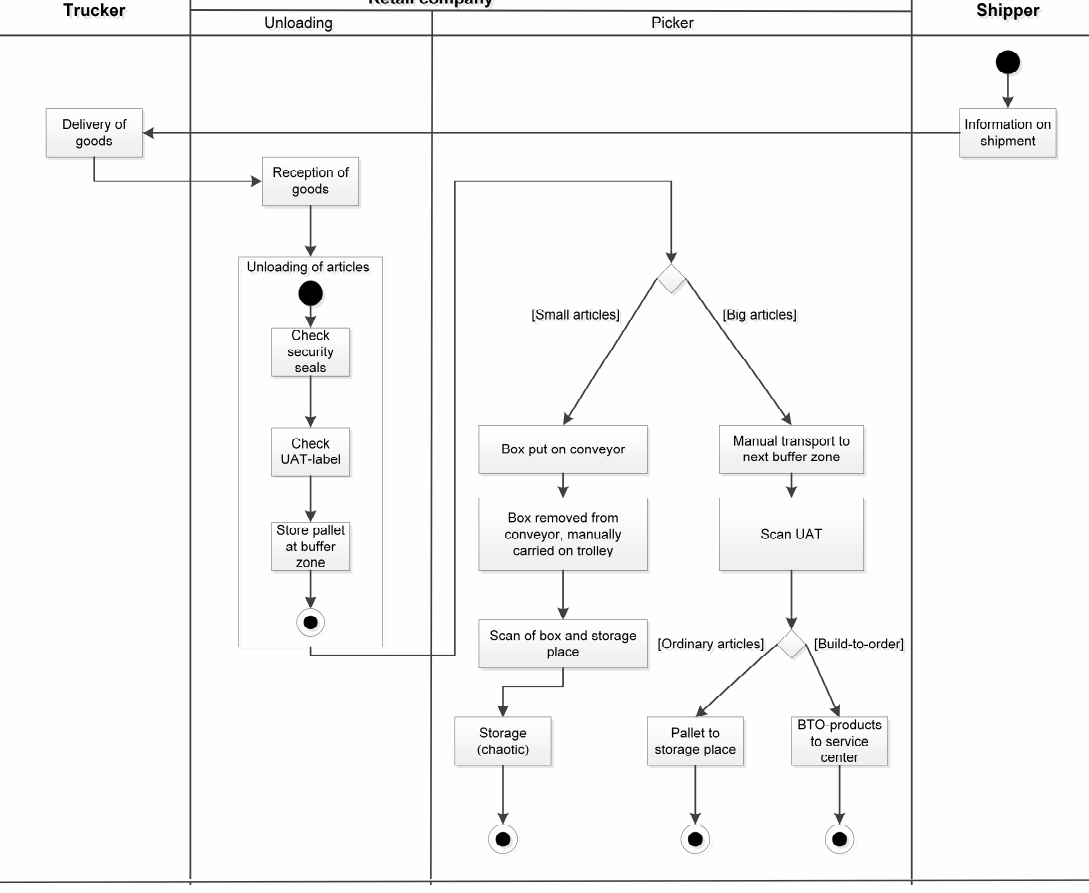
Figure 12. Activity diagram of the storage use case example.